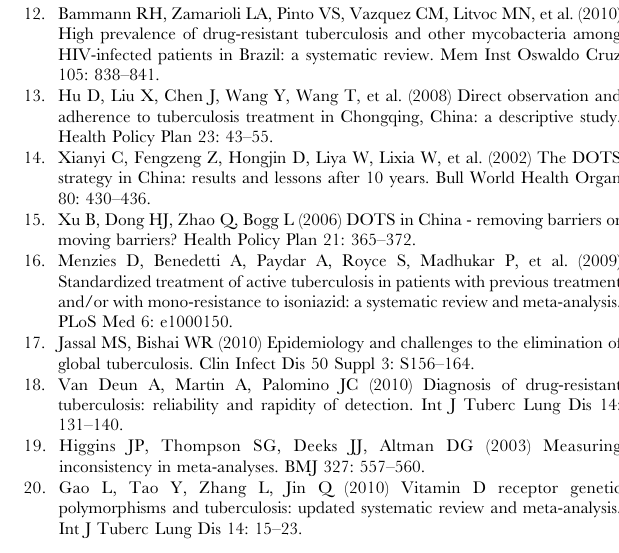
Table S3 Distribution of different patterns of TB drug resistance among new cases in China. Table S4 Distribution of different patterns of TB drug resistance among previously treated cases in